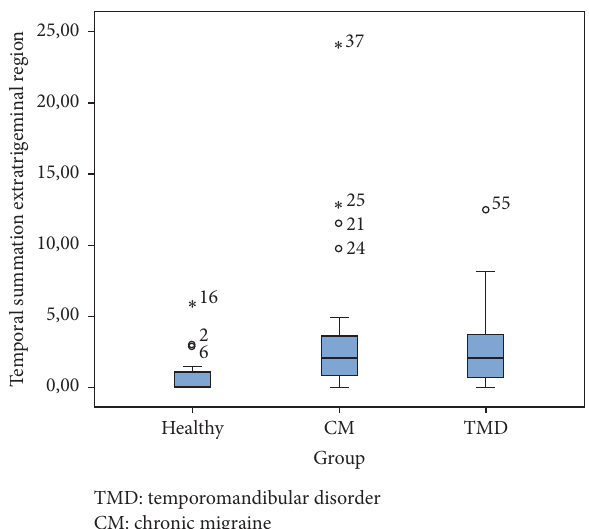
Figure 2: Boxplot for temporal summation in the extratrigeminal